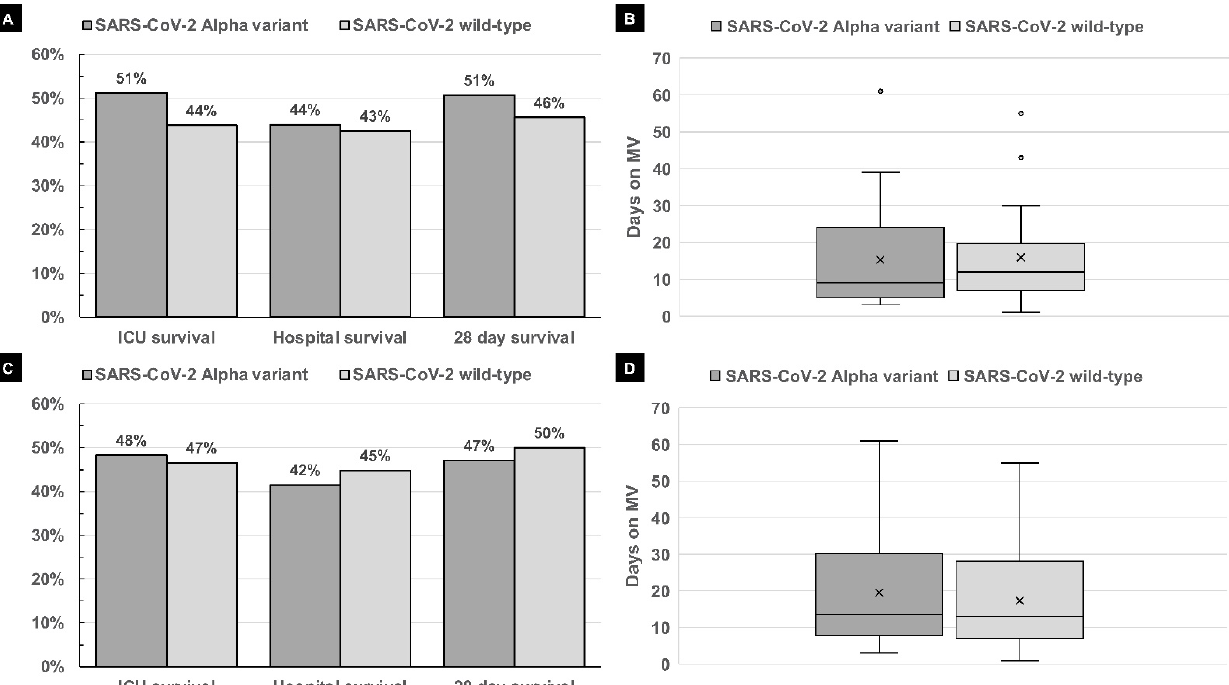
Figure 1. ( A ) ICU survival, hospital survival and 28-day survival in the full patient population in the SARS-CoV-2 Alpha variant group and SARS-CoV-2 wild-type group ( n = 80 each). ( B ) Duration of mechanical ventilation (MV) in days of the entire patient population in the SARS-CoV2 Alpha group and SARS-CoV2 wild-type group ( n = 80 each); X = mean; line inside the box marks the median; the bottom and top of the box correspond to the upper and lower quartiles, respectively; upper and lower whiskers correspond 1.5 times the interquartile range. ( C ) ICU survival, hospital survival and 28-day survival of the matched-pair analysis in the SARS-CoV-2 Alpha variant group and SARS-CoV-2 wild-type group ( n = 58 each). ( D ) Duration of mechanical ventilation (MV) in days of the matched-pair analysis in the SARS-CoV-2 Alpha variant group and SARS-CoV-2 wild-type group ( n = 58 each); X = mean; line inside the box marks the median; the bottom and top of the box correspond to the upper and lower quartiles, respectively; upper and lower whiskers correspond to 1.5 times the interquartile range. No significant differences were detected between the SARS-CoV-2 Alpha variant group and the SARS-CoV-2 wild-type group in any of the illustrated analyses.